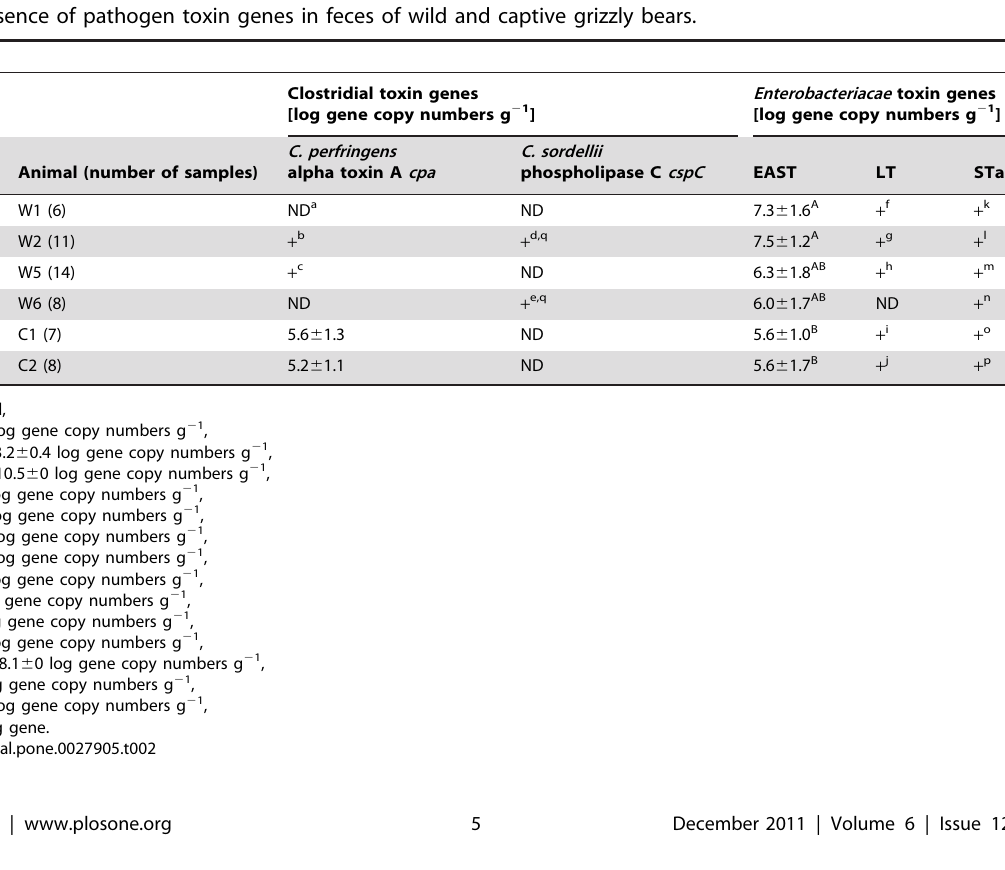
Figure 2. Bacterial groups present in the feces of wild and captive grizzly bears. Bacterial groups (A, total Eubacteria; B, Enterobacteriaceae ; C, Enterococcus ; D, Lactobacillus , Pediococcus , Leuconostoc , Weissella ; E, Clostridium cluster I; F, Clostridium cluster XI, G, Clostridium cluster XIV; H, Bacteroides-Prevotella-Porphyrmonas ) detected in feces of a four wild (W1,W2, W5, and W6) and two captive (C1, C2) grizzly bears during sampling in 2009. Box plots show the 25 to 75% percentile range of the data in the box, the 5 to 95% range (whiskers), the median (middle line), and the mean (dashed line). Outliers are indicated by dots. Boxplots corresponding to the three populations are indicated by colour (population 1 blue, population two turquois, population 3 green). Differences between populations were analysed using one-way ANOVA. If data was not distributed normally, Kruskal-Wallis One Way Analysis of Variance on Ranks was applied (total Eubacteria, Enterobacteriaceae , Enterococcus , Clostridium cluster XI). Populations that do not share a common superscript (A,B) are significantly different (p , 0.05). Abundance of Clostridium clusters I and XI was also compared in wild and captive animals (Kruskal-Wallis One Way Analysis of Variance on Ranks); their abundance was significantly different (p , 0.05) if values for wild and captive animals do not share a common superscript (a,b).